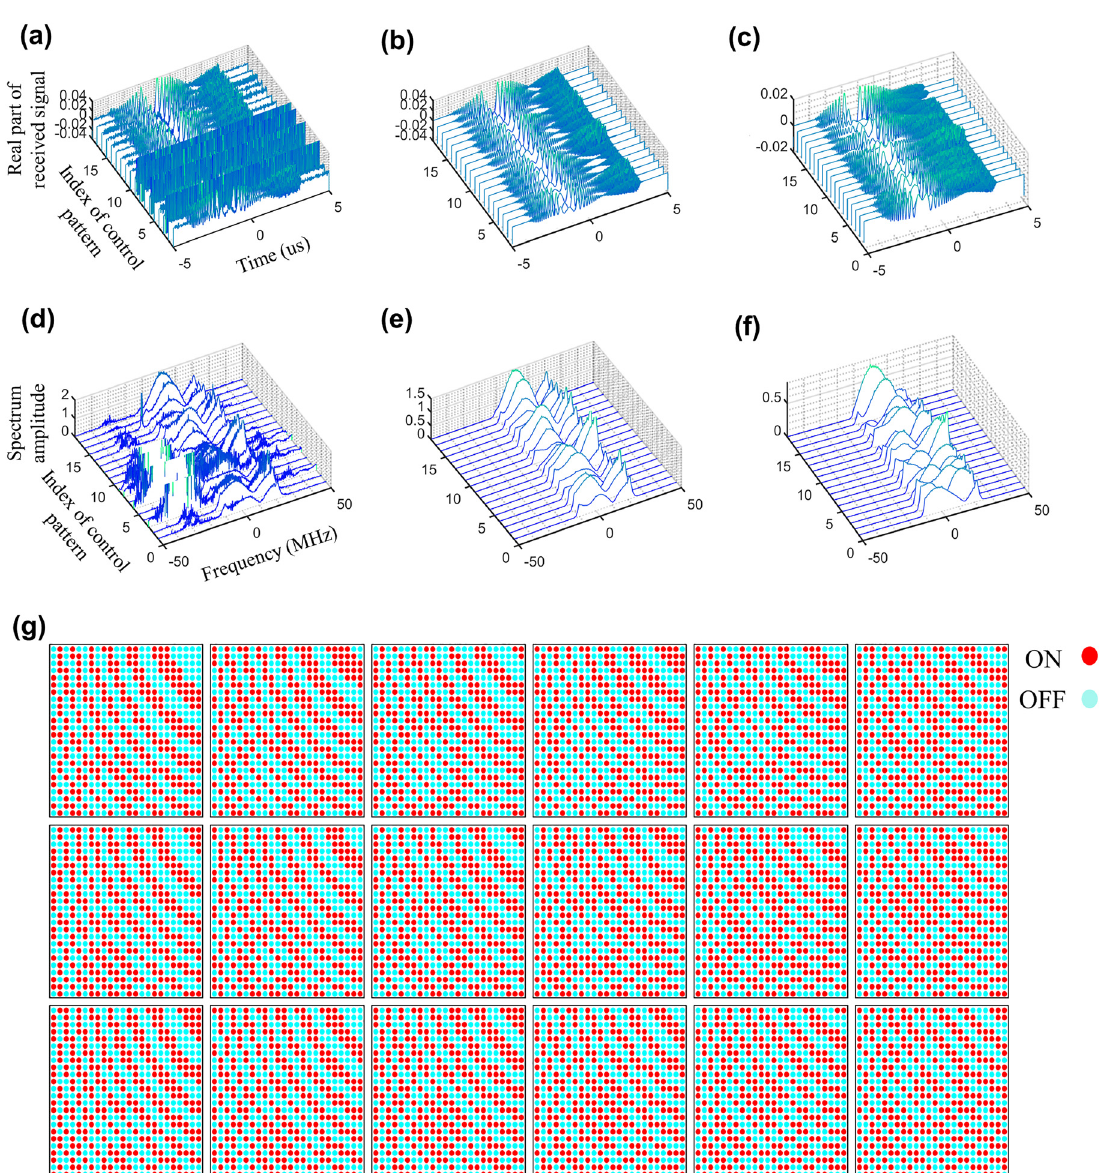
Figure 3: Experimental results of the signal denoise for proposed intelligent EM metasurface camera working at around 2.4 GHz in outdoor